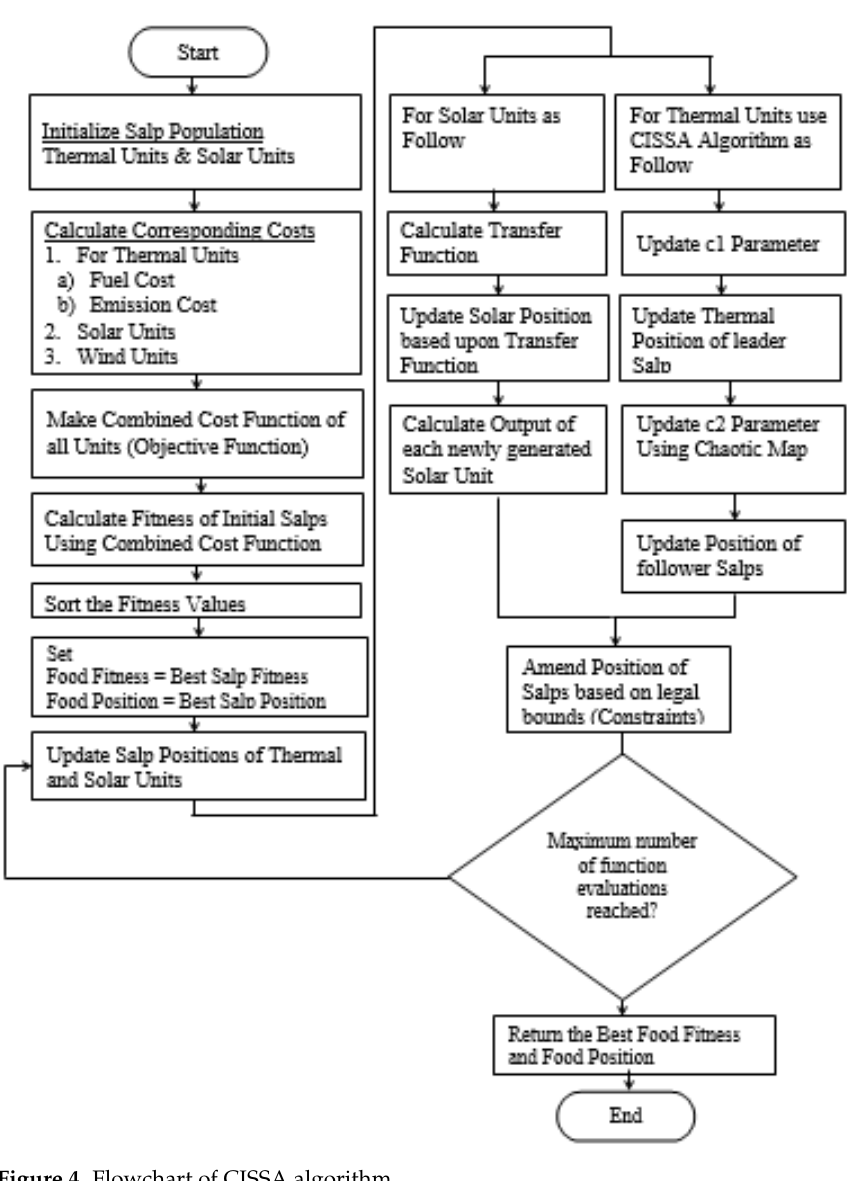
Figure 4. Flowchart of CISSA algorithm.